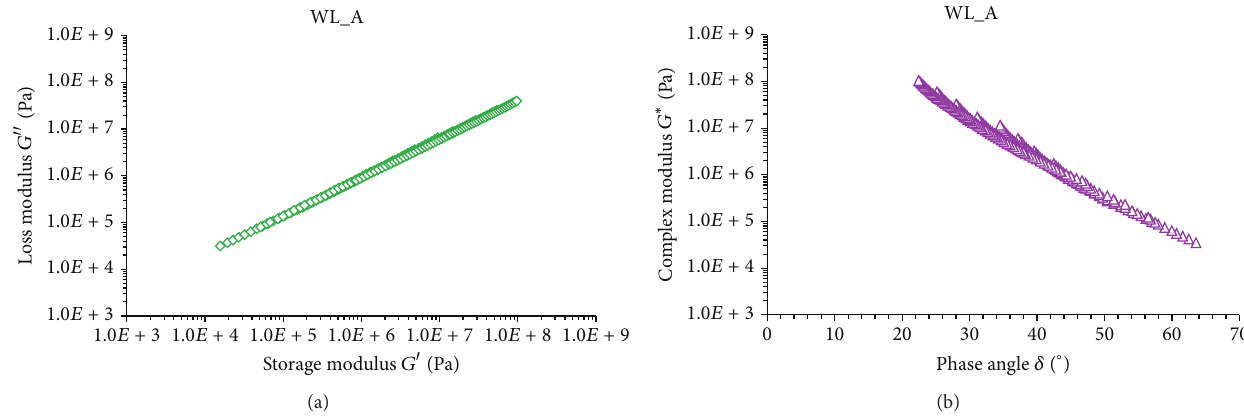
Figure 4: Cole-Cole plot (a) and Black diagram (b) for the complex modulus 𝐺 ∗ (sample WL A).